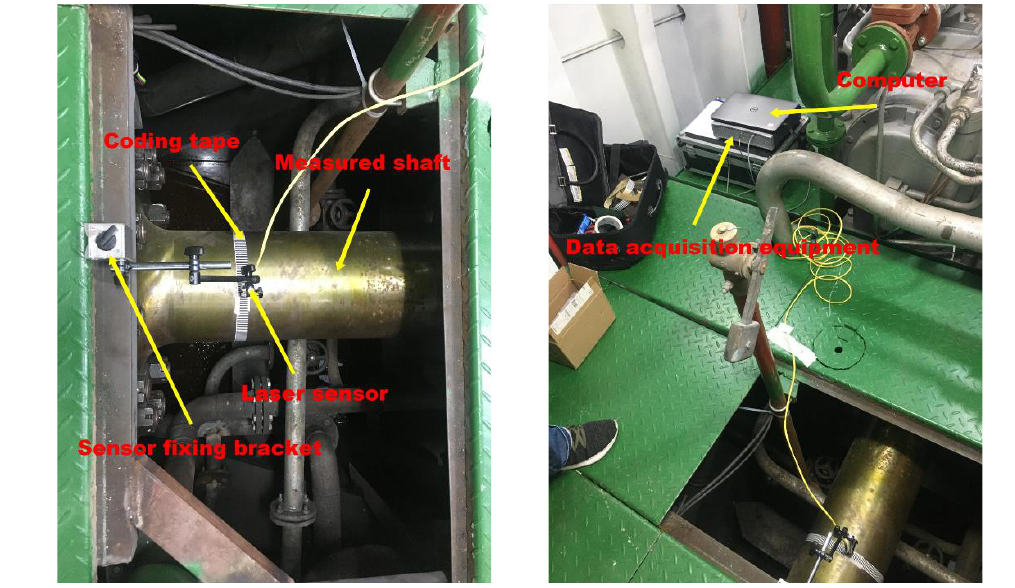
Figure 4. Test equipment installation site.